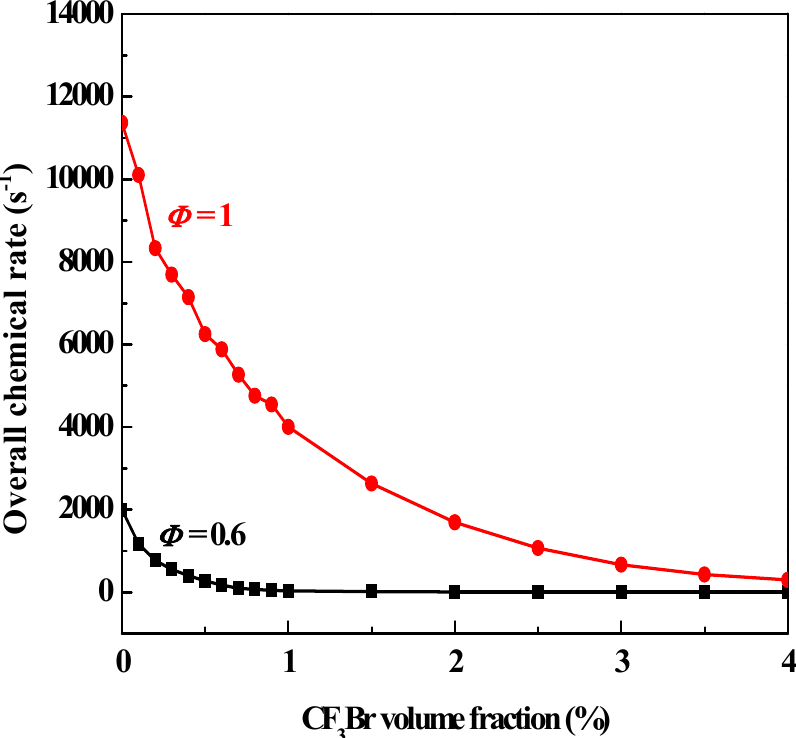
Figure 2. The overall chemical rate at extinction in PSR as a function of CF 3 Br volume fraction in stoichiometric and lean ( Φ = 0.6) CH 4 /air flames at 298 K and 1 bar.